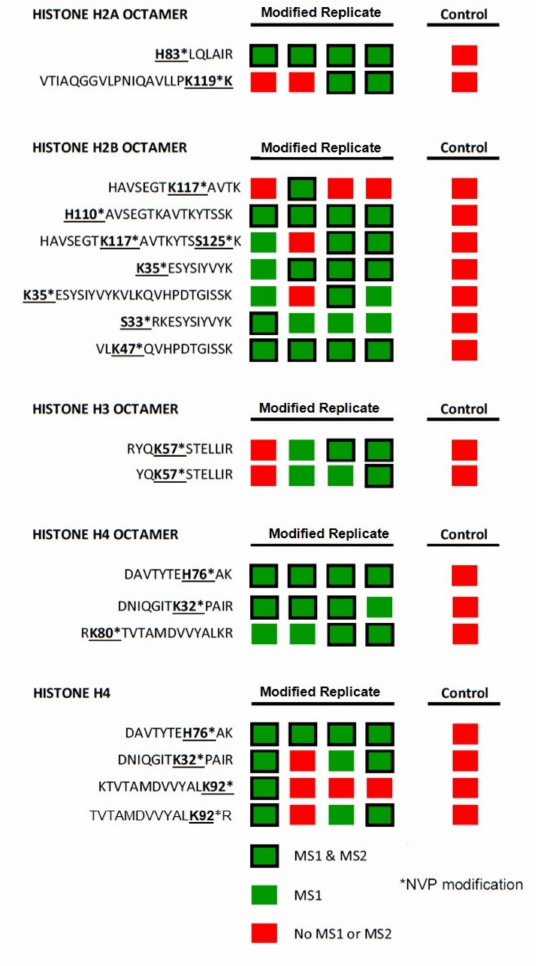
Figure 1. Sequences of nevirapine-modified peptides identified in histones H2A, H2B, H3 and H4, either as purified proteins (H4) or in the octamer structure. Modified peptides observed in each of four replicates are highlighted in green, and a bold border indicates that MS2 information is also present. Modified peptides for which no MS2 evidence was present were identified by ionogram alignment and extraction of the MS1 ion current. Digestion conditions: Two hour trypsin digestion with a 1:10 trypsin:histone